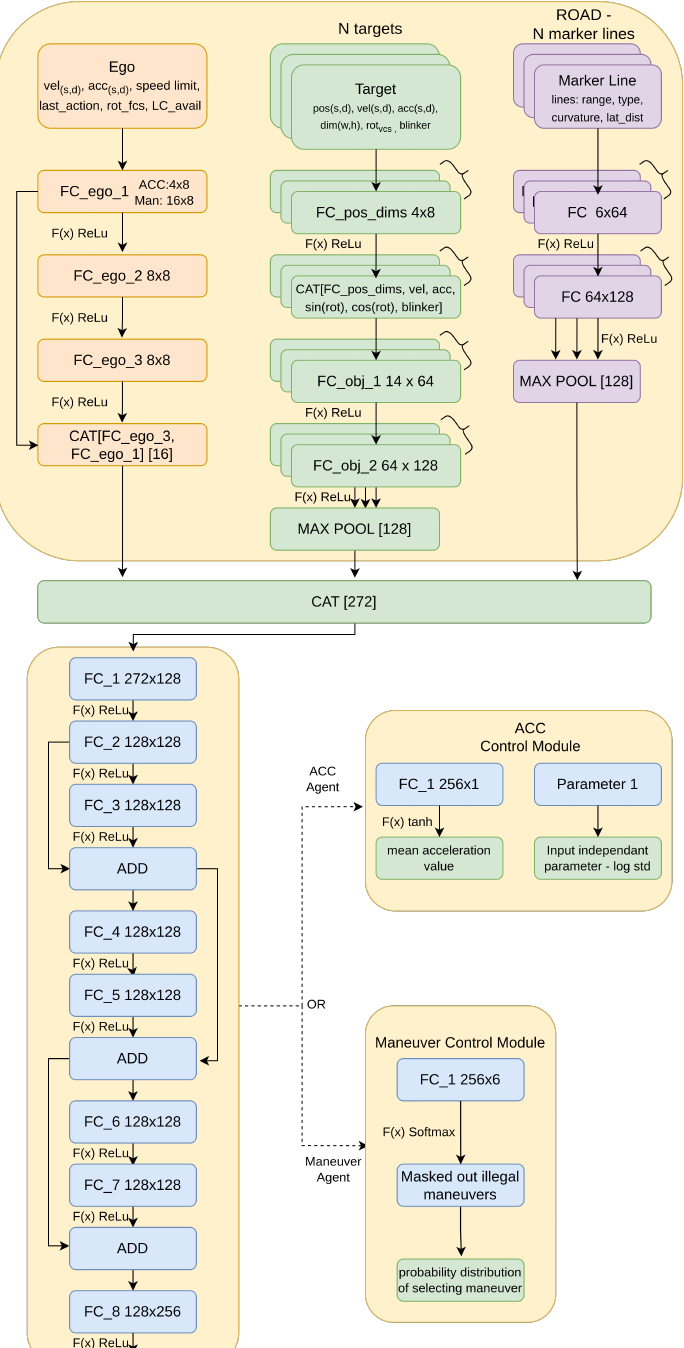
Figure 1. ANN architecture takes as an input vector the representation of traffic situation. It processes input through feed-forward layers and 3 residual blocks. Each agent has a different control module that produces the probability distribution parameters of selecting an action and slightly different input layers due to the different definitions of observations. FC—fully connected layers with bias; CAT—operation of features concatenation; means that layers have shared weights (e.g., each target is processed by the same